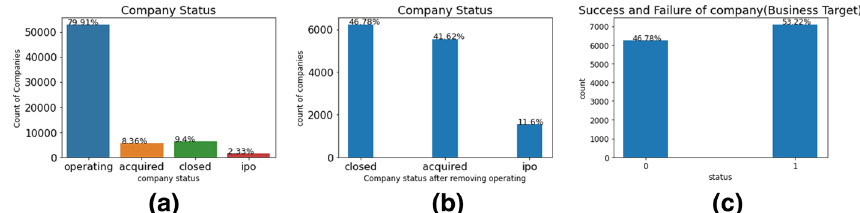
Fig. 1 Statistics of company status with respect to four categories ( a ); statistics after removing Operating ones ( b ); c statistics of the final